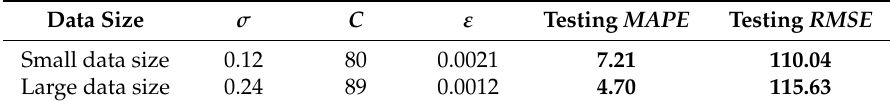
Table 5. The SVR-PSO’s parameters for Data-I (Example 2).